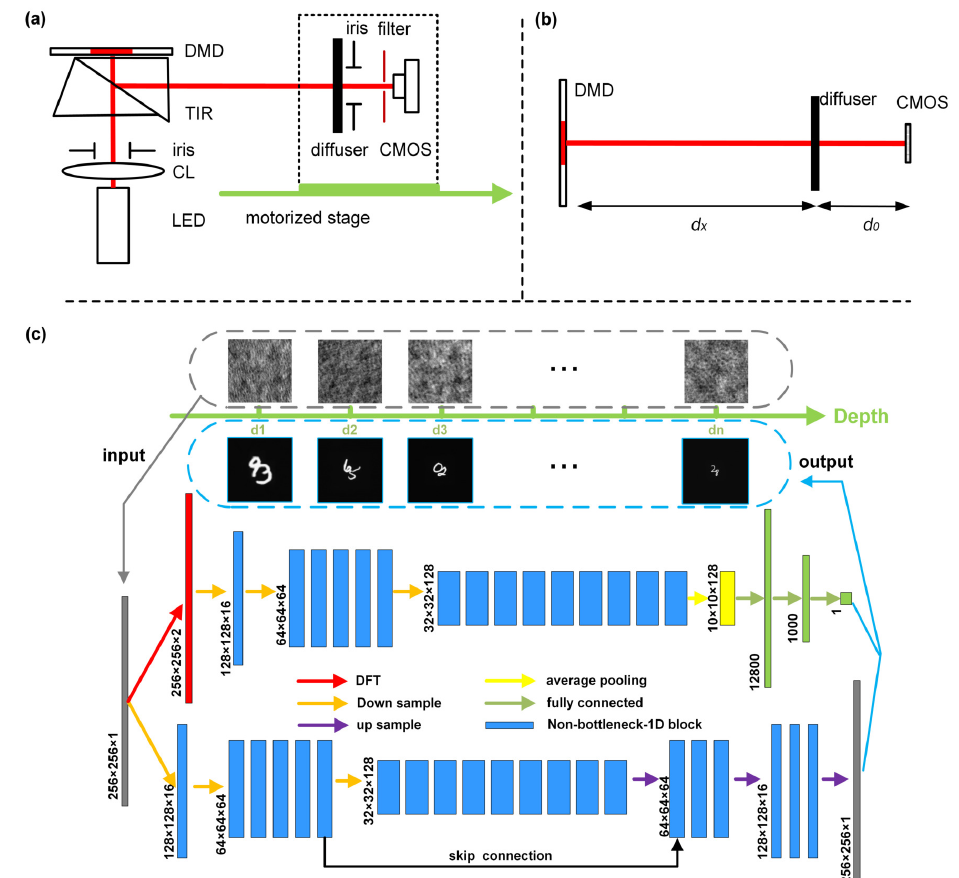
Figure 1. Systematic configuration. ( a ) Experimental arrangement. CL, collimating lens; TIR, total internal reflection prism; DMD, digital micro-mirror device. ( b ) Description of imaging distance with optical path unfold. ( c ) Schematic diagram of DINet